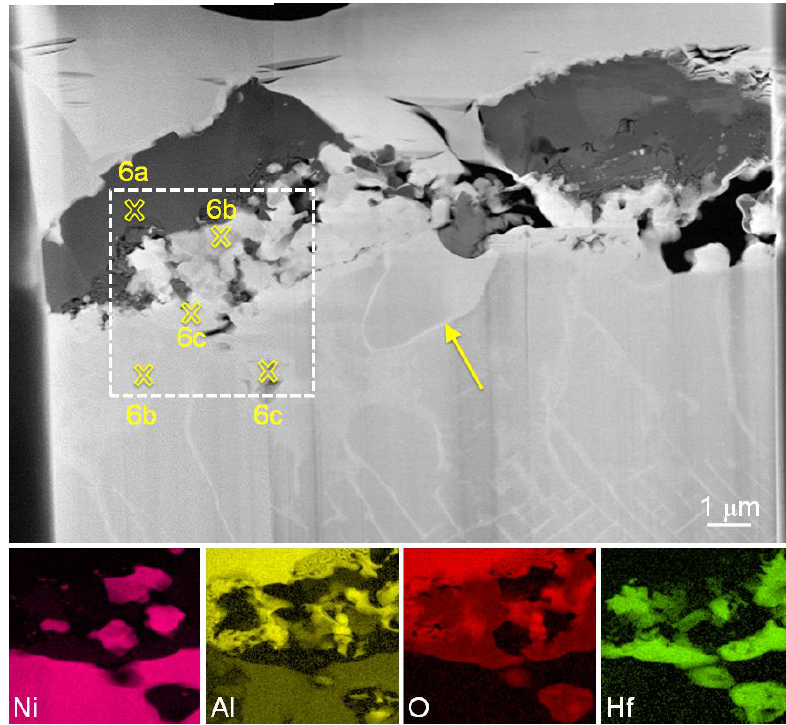
Figure 5. A STEM-HAADF image of the region of interest in Figure 4b after FIB in-situ TEM sam- pling and STEM-EDX element maps of nickel, aluminium, oxygen, and hafnium in the marked re- gion.